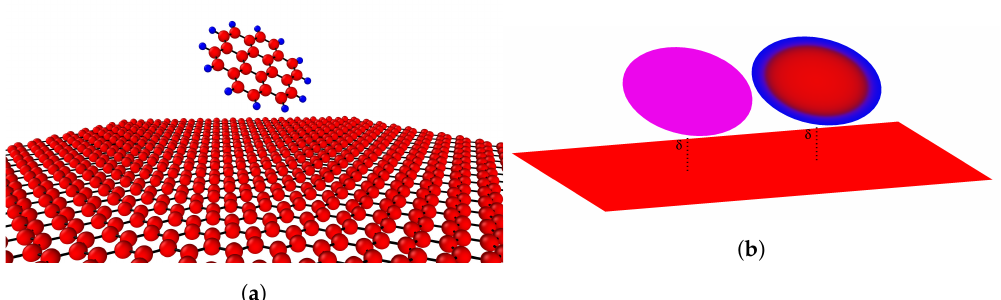
Figure 1. ( a ) Atomistic model of interaction; and ( b ) homogeneous continuous and heterogeneous continuous